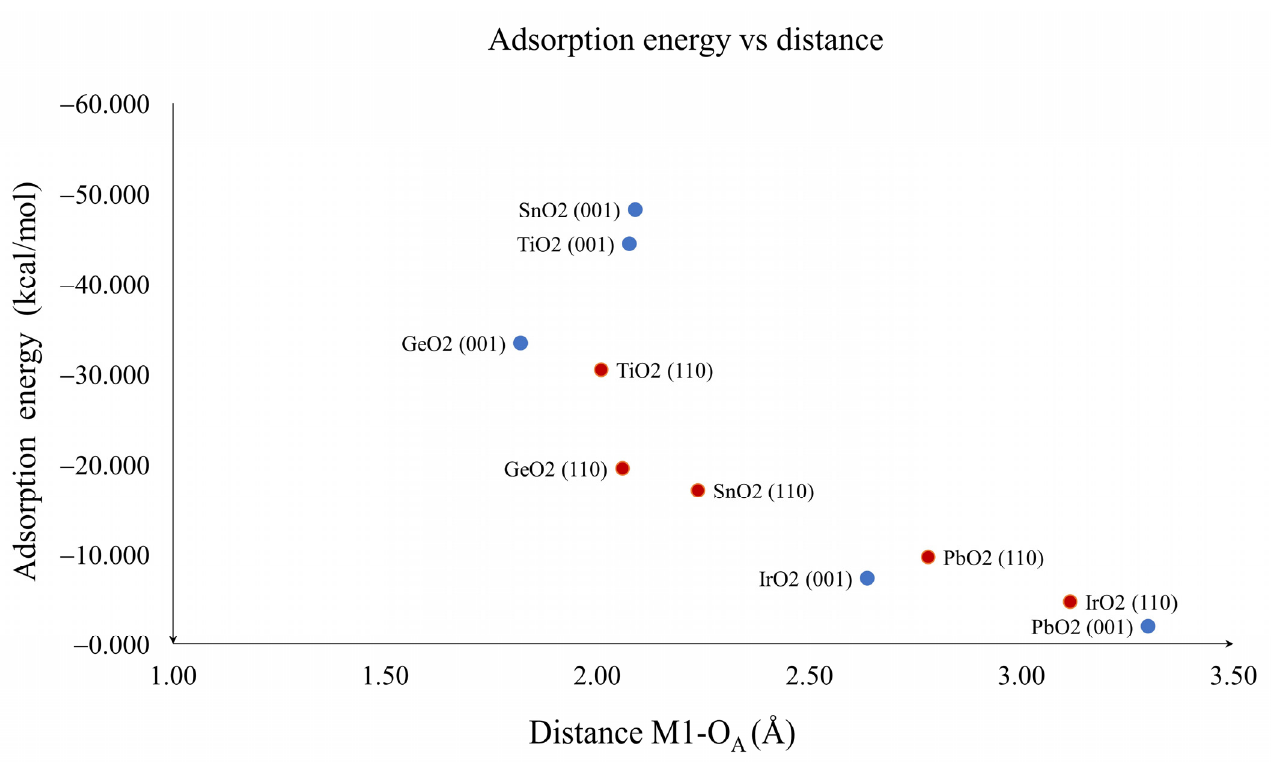
Figure 5. Relation between adsorption energy and M1-O A distance for TiO 2 , GeO 2 , SnO 2 , IrO 2 and PbO 2 . (001) planes are blue dots and (110) planes are red dots.